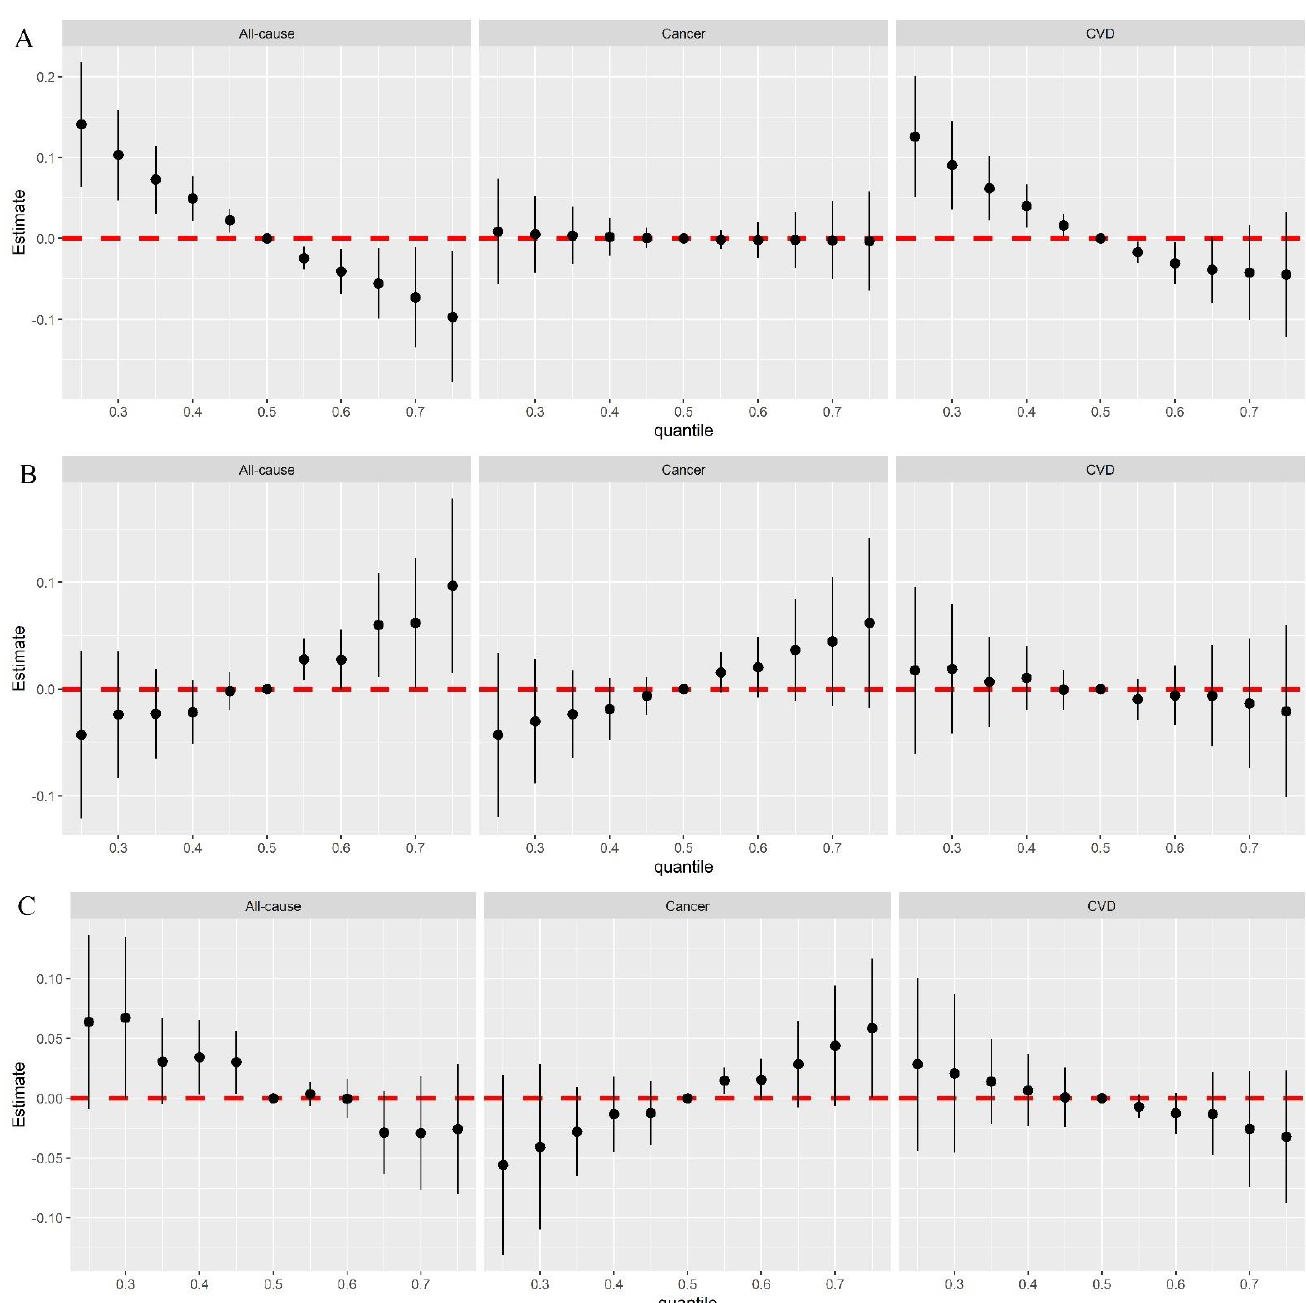
Figure 3. The estimated associations of ( A ) vitamin biomarkers mixture, ( B ) trace metal biomarker mixtures, and ( C ) other biomarker mixtures with all − cause and cause − specific mortality risk with 95% confidence intervals. The X − axis shows percentiles of biomarkers mixtures. The Y − axis shows the estimated change in risk of all − cause mortality. The lines of the plot show the overall effects of the mixture (estimates and 95% CIs) in mortality risk when biomarkers are all at a particular percentile compared to when biomarkers are set at the 50th percentile.